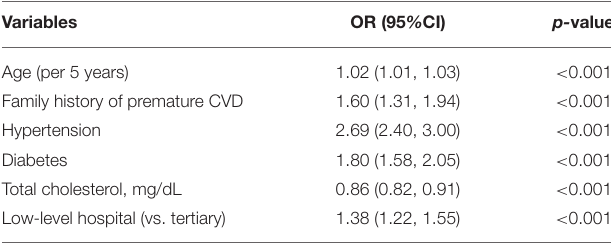
TABLE 3 | Independent risk factors of aspirin overuse by multivariate logistic regression analysis for patients with low